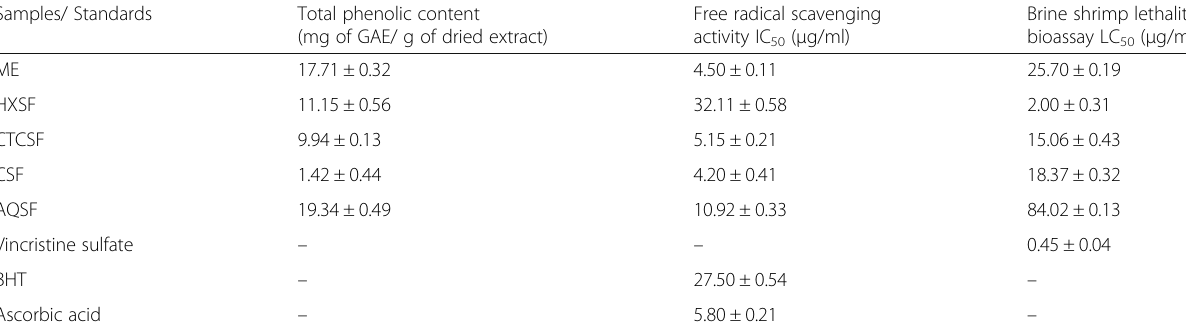
Table 1 Antioxidant and cytotoxic activities of L. speciosa flower extract and soluble fractions Samples/